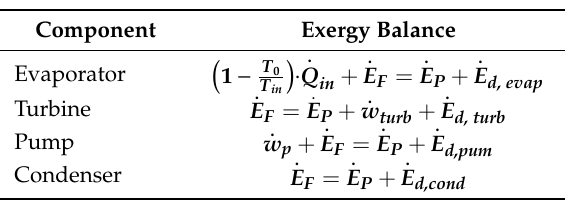
Table 2. Balance of exergy in